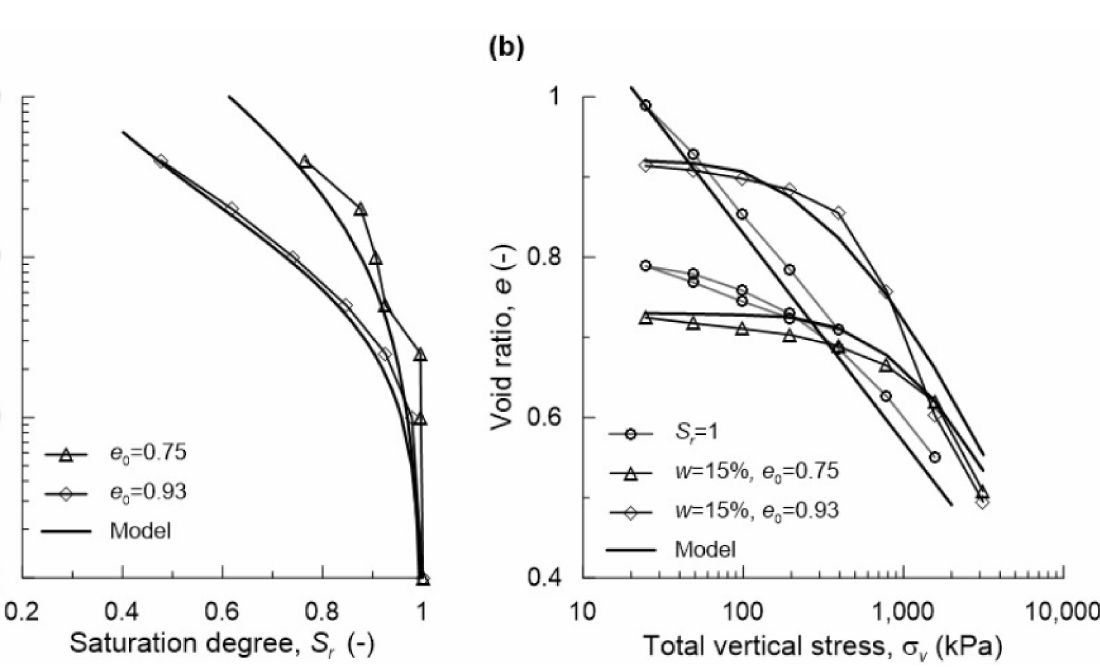
Figure 2. Numerical model calibration, ( a ) soil water retention curves SWRCs, ( b ) oedometer